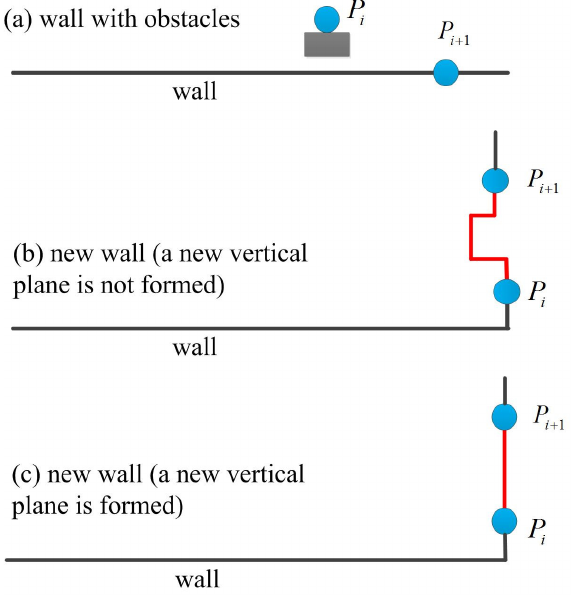
Figure 5. New vertical plane detection.